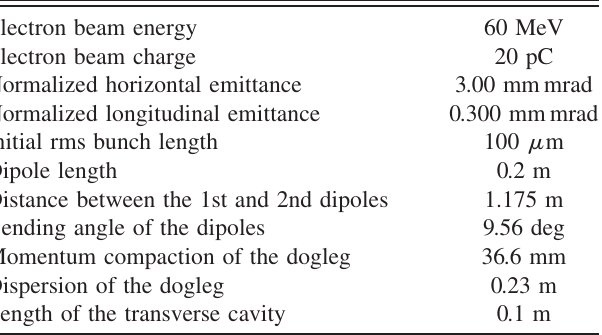
TABLE I. Main beam and EEX beam line parameters at NLCTA.